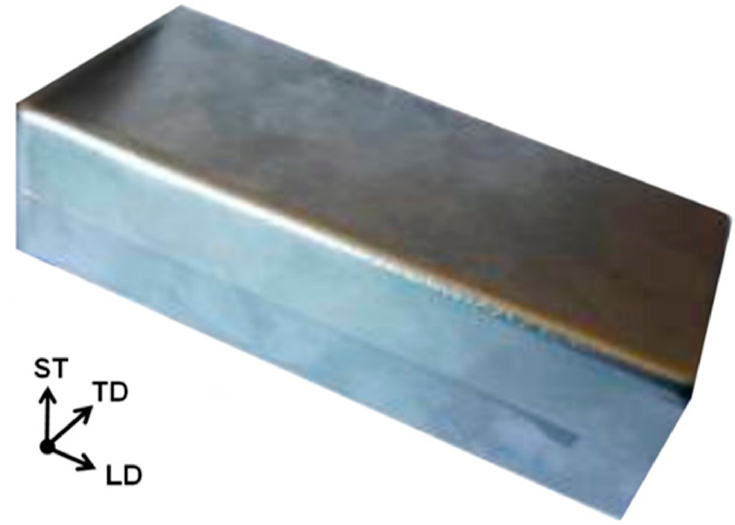
Figure 1. Ti-6Al-4V alloy ingot, where ST, TD and LD correspond to short transverse, transversal and longitudinal directions, respectively. Table 1. Chemical composition of the studied Ti-6Al-4V alloy (wt.%).